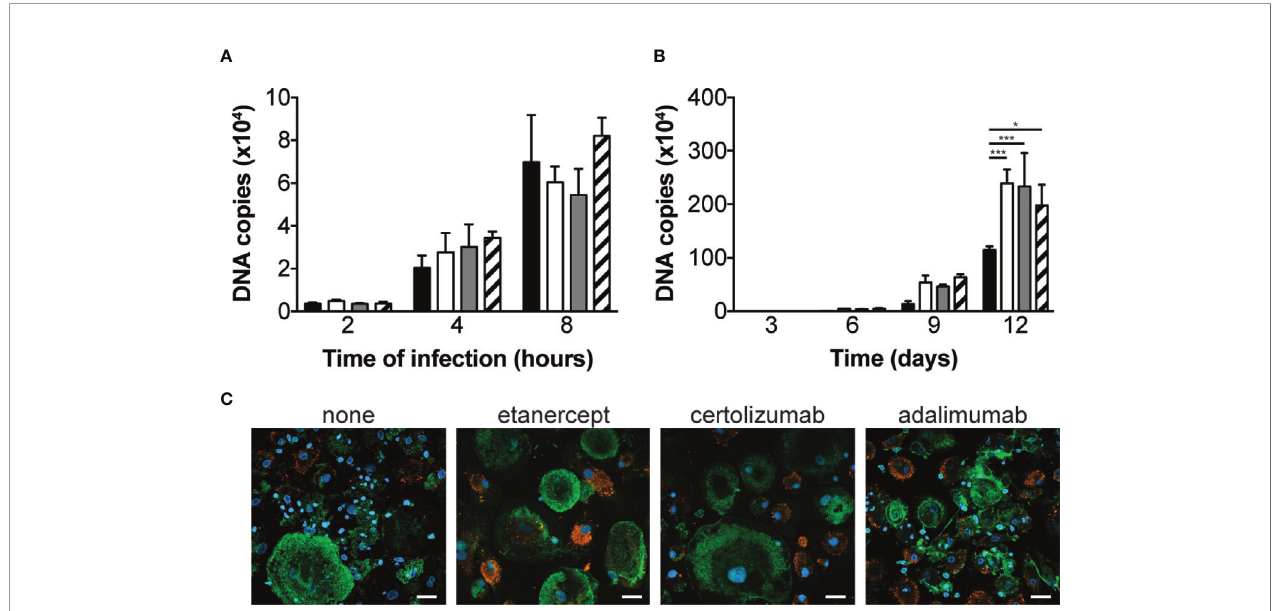
FIGURE 1 | TNFI increase T. whipplei replication in macrophages. (A) Macrophages were infected with T. whipplei (50 bacteria per cell) alone (black bars) or in the presence of etanercept (white bars), certolizumab (grey bars) or adalimumab (hashed bars) and washed after 2, 4 or 8 h. (B) Macrophages were infected with T. whipplei (50 bacteria per cell) alone (black bars) or in the presence of etanercept (white bars), certolizumab (grey bars) or adalimumab (hashed bars) for 4 h, washed to remove free bacteria and incubated for the indicated periods with etanercept (white bars), certolizumab (grey bars) or adalimumab (hashed bars) or left untreated (black bars). Bacterial DNA copy number was determined by qPCR. (C) Representative pictures of infected macrophages incubated for 12 days under the indicated treatment and stained with an anti - T. whipplei antibody (red), phalloidin (green) and DAPI (blue), scale bar = 20 m m). The experiment was performed using three different donors (N = 3), and the values represent the mean ± standard error of the mean. * and *** P < 0.05 and 0.001, respectively by two-way ANOVA and the Dunnett ’ s test for post-hoc